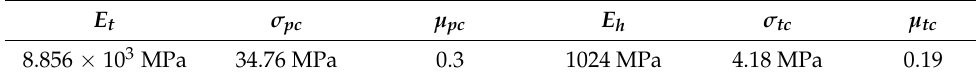
Table 1. The mechanical properties of timber used in the experiment.